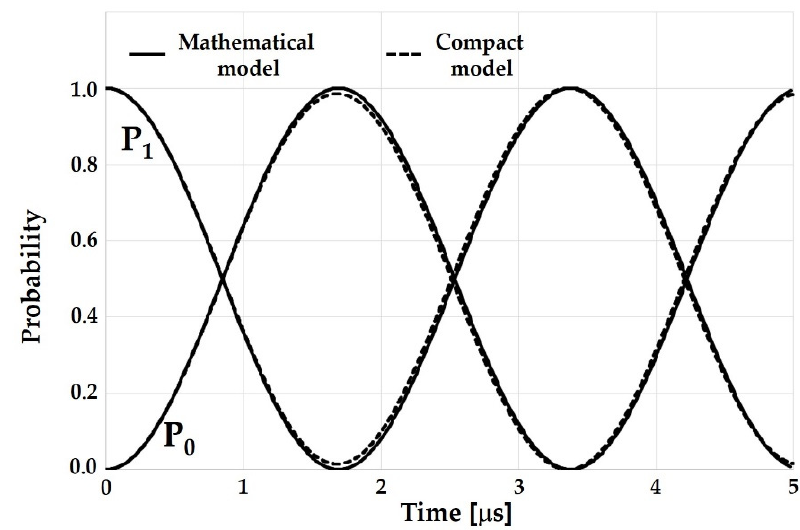
Figure 3. Compact model simulated vs analytically calculated Rabi oscillations.